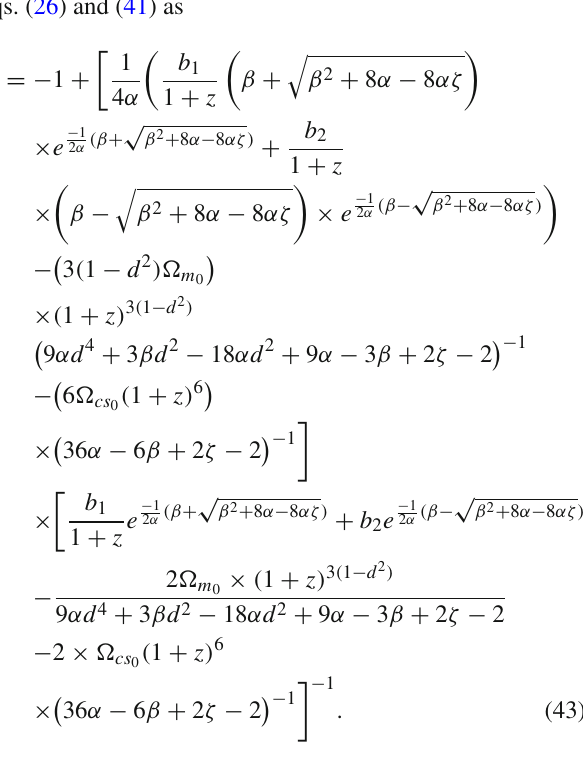
For model 2: , one can get deceleration parameter by